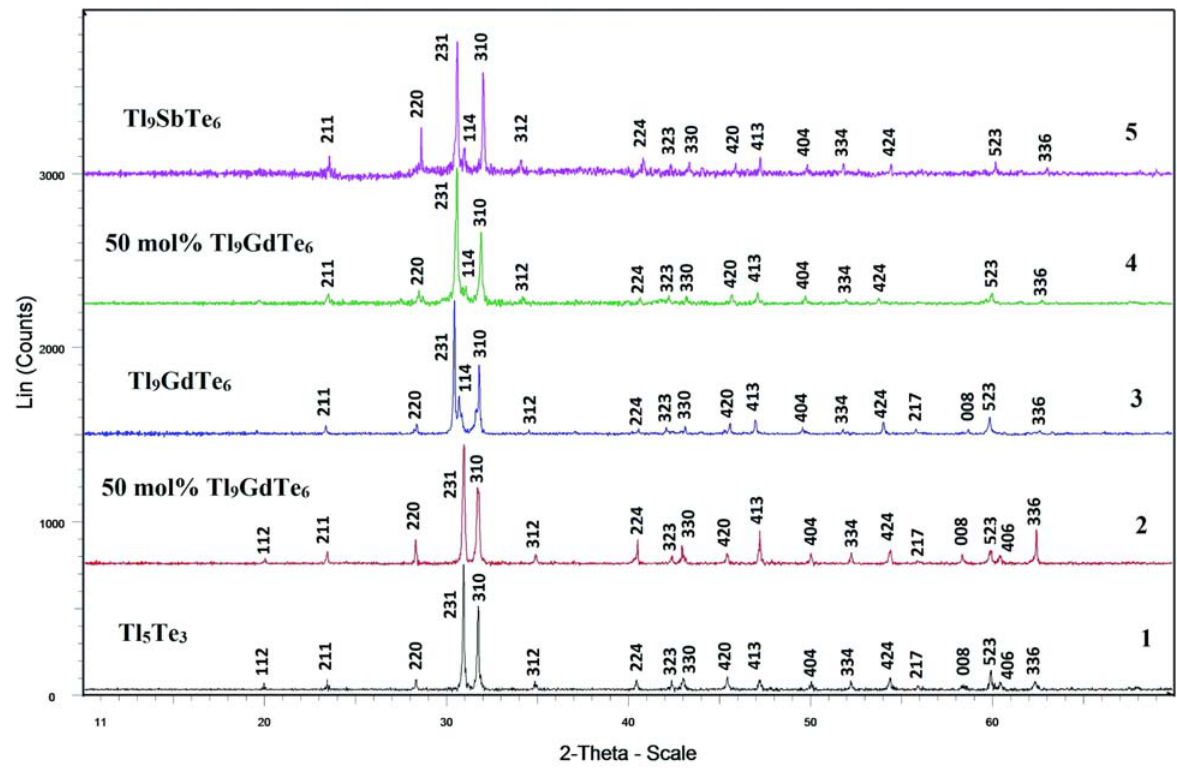
Fig. 3. XRD patterns for different compositions in the Tl 2–50 mol % Tl